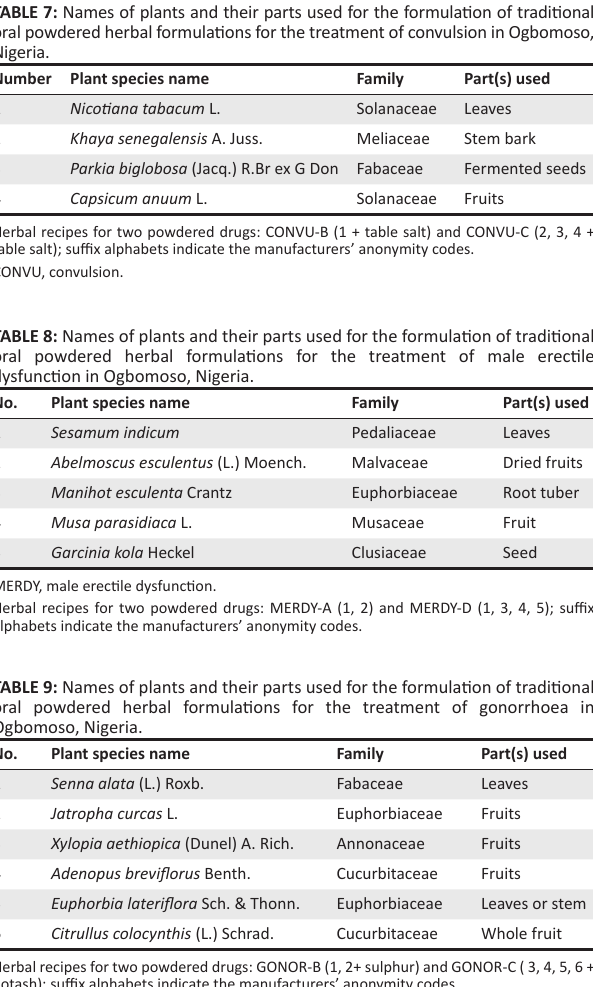
Herbal recipes for two powdered drugs: GONOR-B (1, 2+ sulphur) and GONOR-C ( 3, 4, 5, 6 + potash); suffix alphabets indicate the manufacturers’ anonymity codes. GONOR, gonorrhoea.